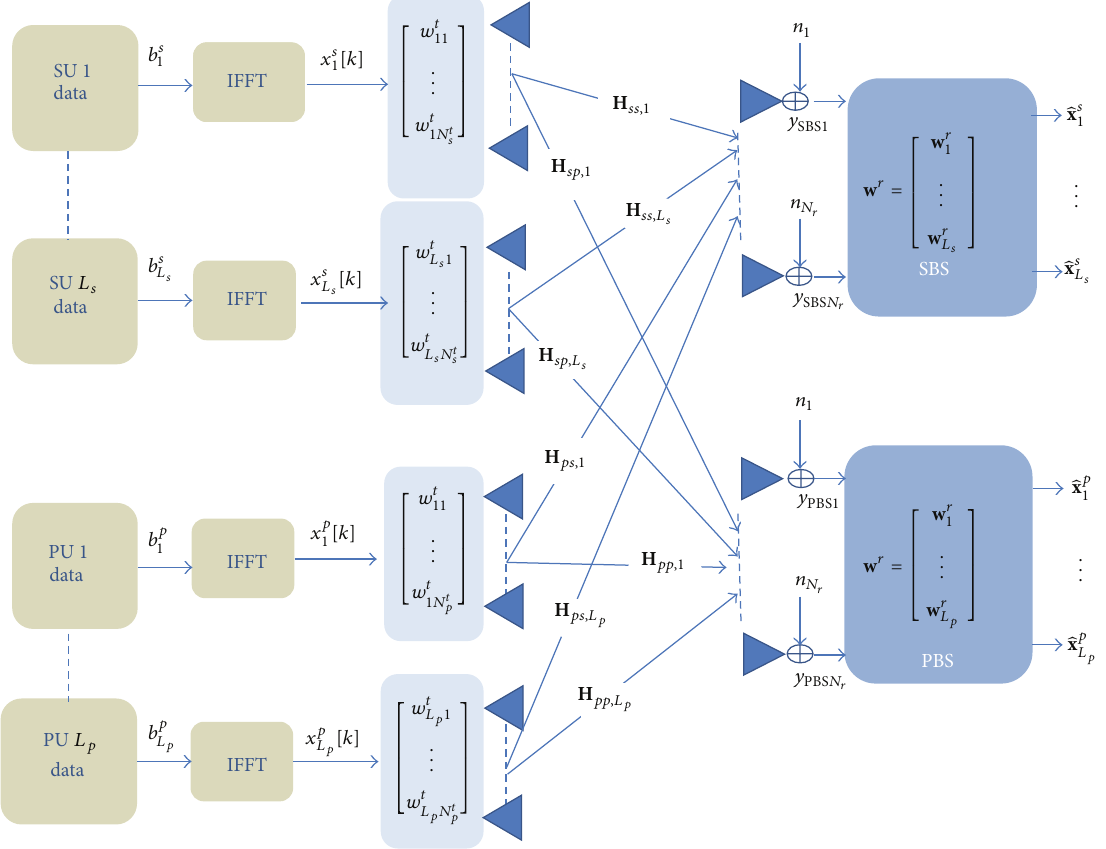
Figure 1: System model: primary and secondary OFDM-SDMA